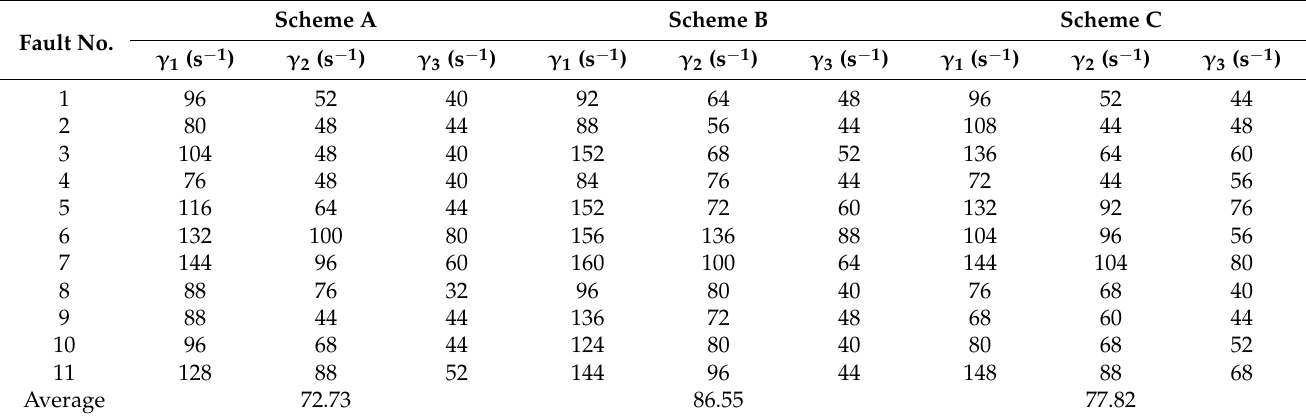
Table 12. Fault diagnosis time (s) in incipient